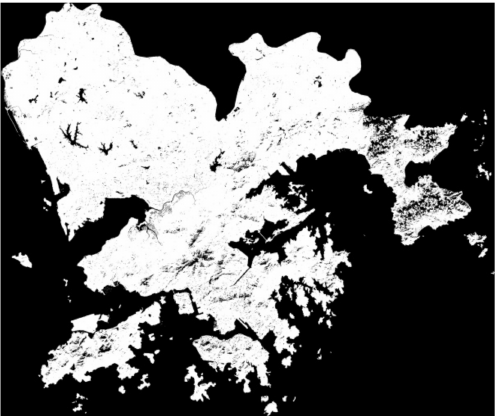
Figure 5. An example of the land area of Hong Kong and Shenzhen in 2016 after the water was masked.